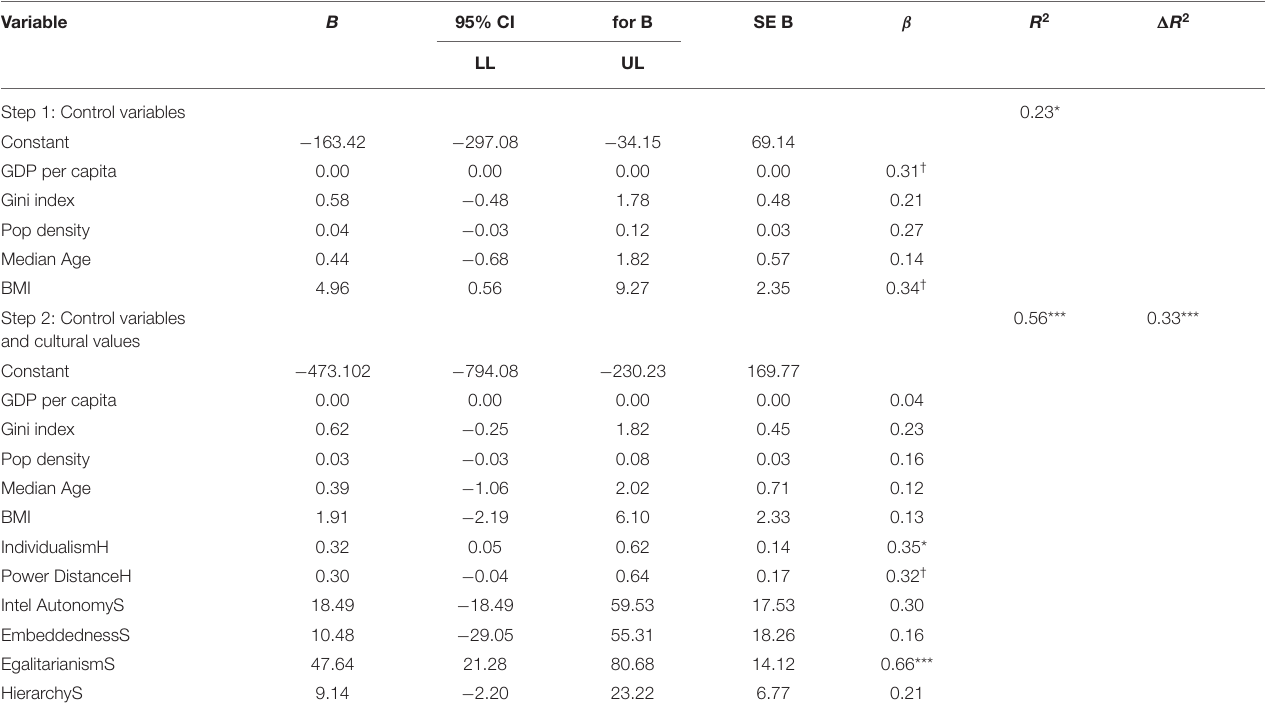
TABLE 4 | Hierarchical regression results for COVID-19 deaths per 100,000 people on July 14, 2020